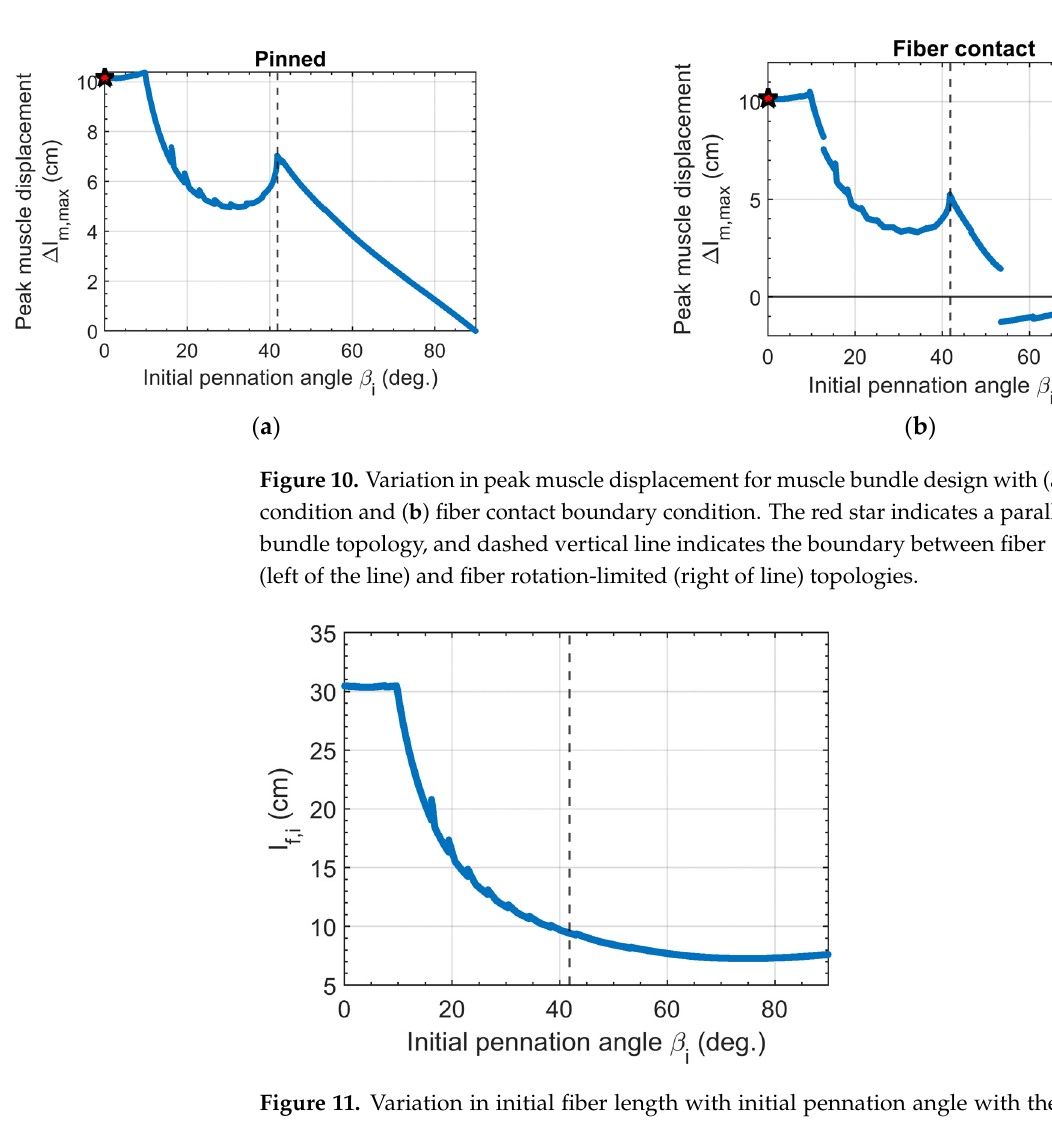
Figure 11. Variation in initial fiber length with initial pennation angle with the pinned boundary condition. The dashed vertical line indicates the boundary between fiber contraction-limited (left of the line) and fiber rotation-limited (right of line) topologies.